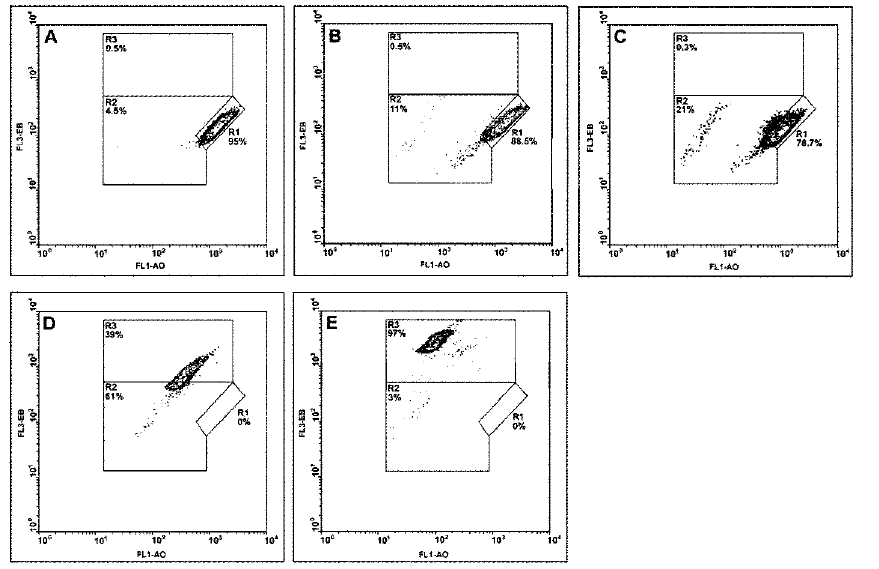
Fig. 5. Biparametric contour plots of green fluorescence (FL1, xx 0 axis) versus red fluorescence (FL3, yy 0 axis) of HL60 cells stained simulta- neously with AO and EB. Region 1 (R1) of AO high –EB low staining corresponds to viable cells; early apoptotic cells are distributed to region 2 (R2) (AO low –EB low ), and late apoptotic and necrotic cells are distributed to region 3 (R3) (AO low –EB high ). A, control culture; B, C, D and E, cells irradiated for 3 sec, 15 sec, 25 min and 1 h, respectively. Percentages of R1, R2 and R3 cells are shown in the figures. One representative experiment out of three is